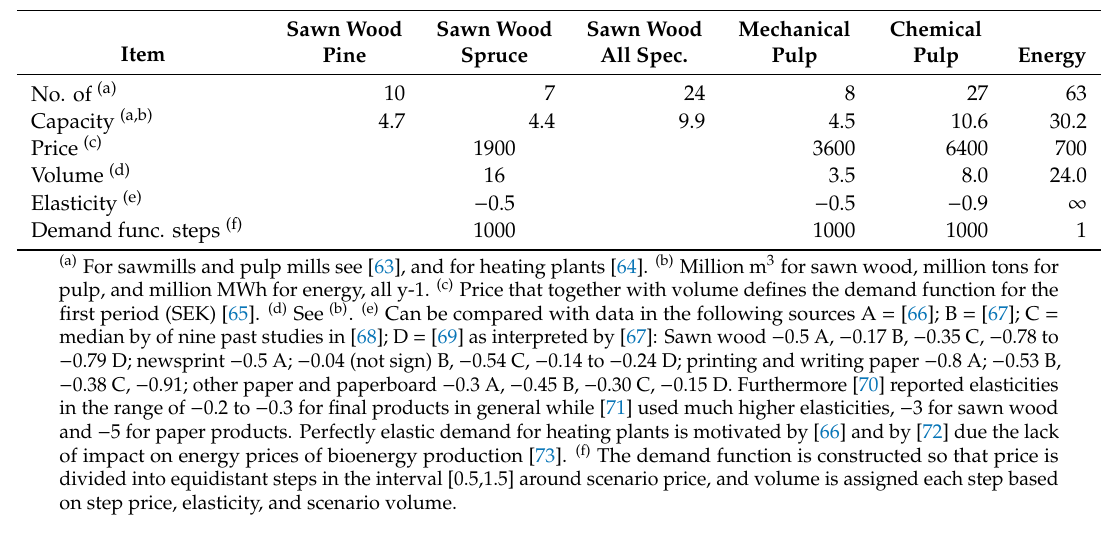
Table A28. Demand-side model